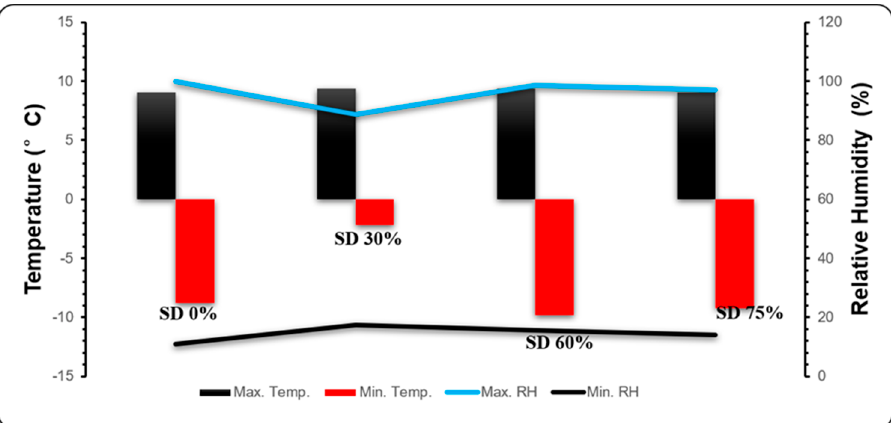
Figure 2. Novel climatic pattern of temperature (°C), maximum temperature (Max. Temp.), minimum temperature (Min. Temp.), relative humidity (%), maximum relative humidity (Max. RH, and minimum relative humidity (Min. RH) of different shading treatments for control SD (0%), shading net SD (30%), shading net SD (60%), shading net SD (75%) during mild and extreme cold conditions.